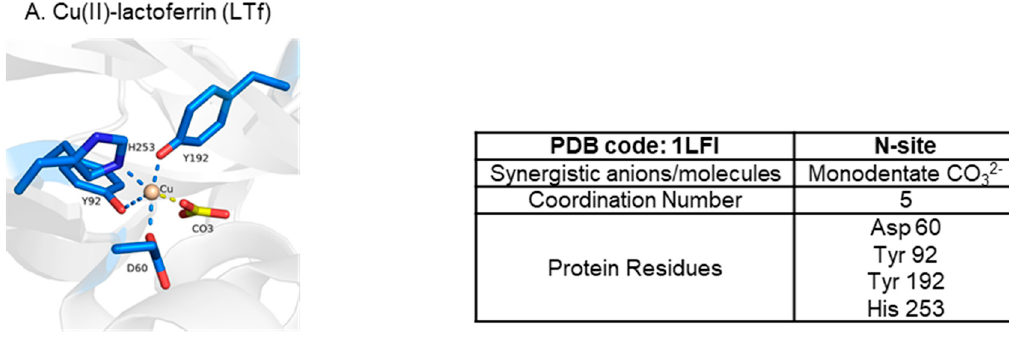
Figure 12. X-ray structures of sTf coordination of Cu(II) ( A ), Sm(III) ( B ), and Bi(III) ( C ) in noncanonical modality. An intriguing finding is that a high affinity of a metal ion to sTf does not correlate with a strong interaction of the metal-sTf complex to the TfR (Table 1). The discrepancy can be attributed to two possibilities. Gallium(III) (Ga(III)) represents one possibility. It is a non-redox active chemical mimic of Fe(III) that is capable of binding with similar affinity to biological ligands and potentially interfere with Fe-dependent processes [56]. It undergoes extensive hydrolysis in aqueous solution especially at pH 7.4 [57]. The propensity for Ga(III) hydrolysis is so high that although sTf can bind Ga(III) with high affinity (log K 1 = 20.3) [58], Ga(III) hydrolysis can compete with sTf binding. The higher the concentration of Ga(III) in solution, the more it may distribute between sTf and hydrolyzed oxo/hydroxo species. This competitive interplay can affect the interaction of Ga(III)-bound sTf with the TfR as there may be a more open and closed conformation dynamic with Ga(III)-bound sTf. Table 1. M n + -sTf affinity and detection of M n + -sTf complexes with TfR. Metal Ion (M n + )